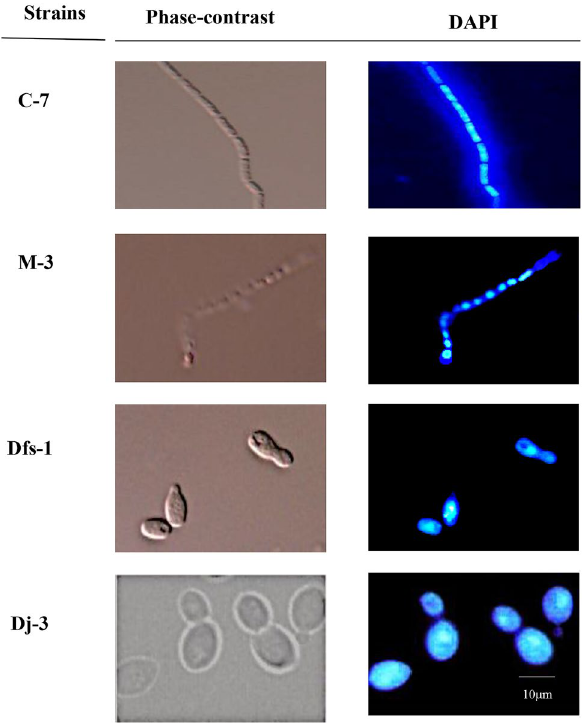
Figure 1. Fluorescent microscopic image of thermotolerant adapted strains. The left and right panels represent phase contrast and DAPI images, respectively, to observe the shape, sizes and nucleoids area on to the cell. The procedure for cell culture, preparation and fixation for microscopic study are detailed in the “Methods” section. Scale bar represents 10